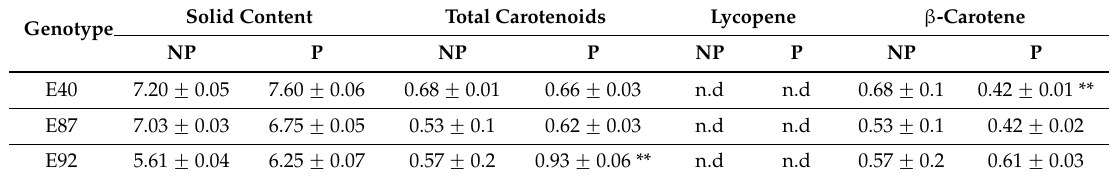
Table 1. Solid content (g/100 g FW), total carotenoids (mg/100 g FW), lycopene (mg/100 g FW)